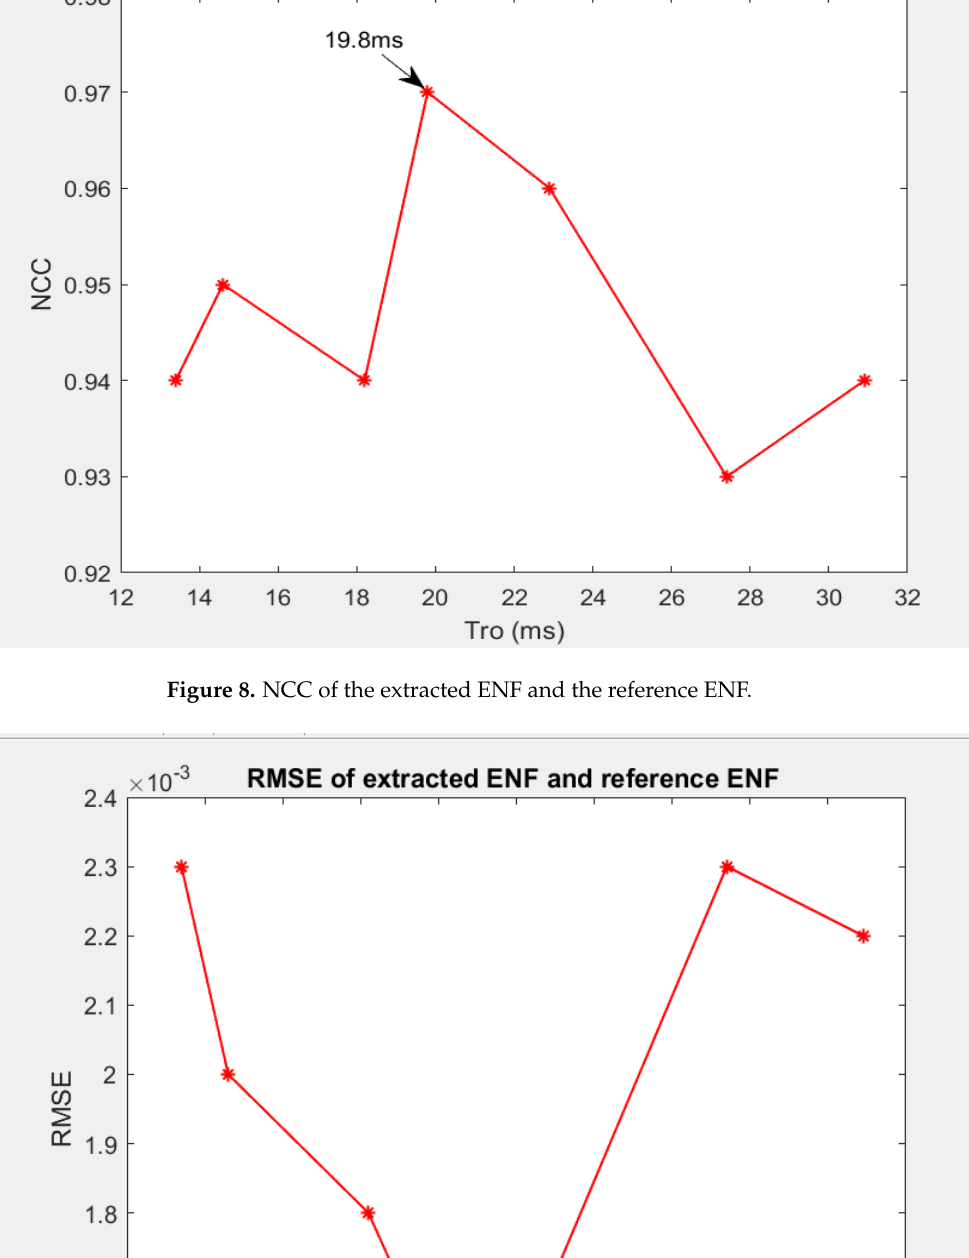
Figure 7. Sample of the ENF signal extracted from a video file (red) using a 𝑇 𝑟𝑜 value of 30.9 ms (iPhone 6) and matched against the reference signal (black). The bottom right corner shows the measure of similarity and dissimilarity between the extracted signal and the reference signal.